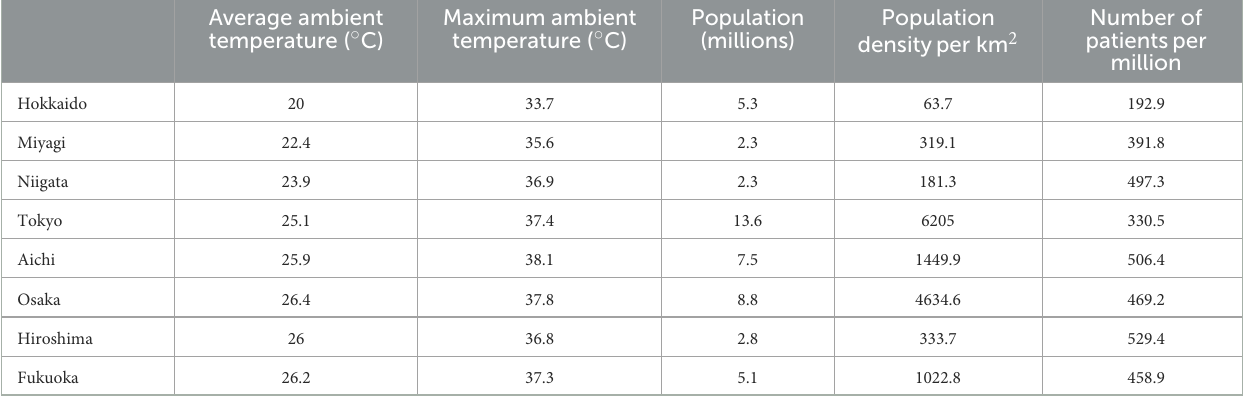
TABLE 1 Daily average and maximum ambient temperature per summer from June 1 to September 30, average population and population density, and average number of patients due to heat-related illness per million population per summer from June 1 to September 30, all data from 2013 to 2019.